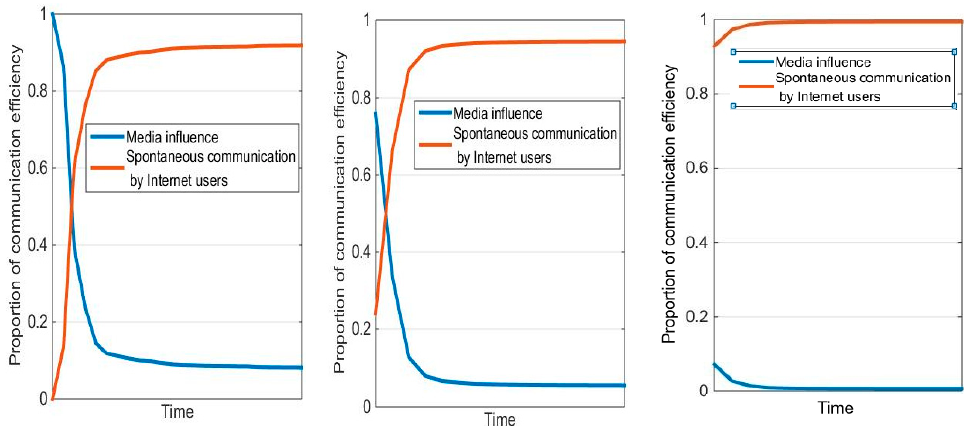
Figure 4. Contrast between media communications and spontaneous communication.